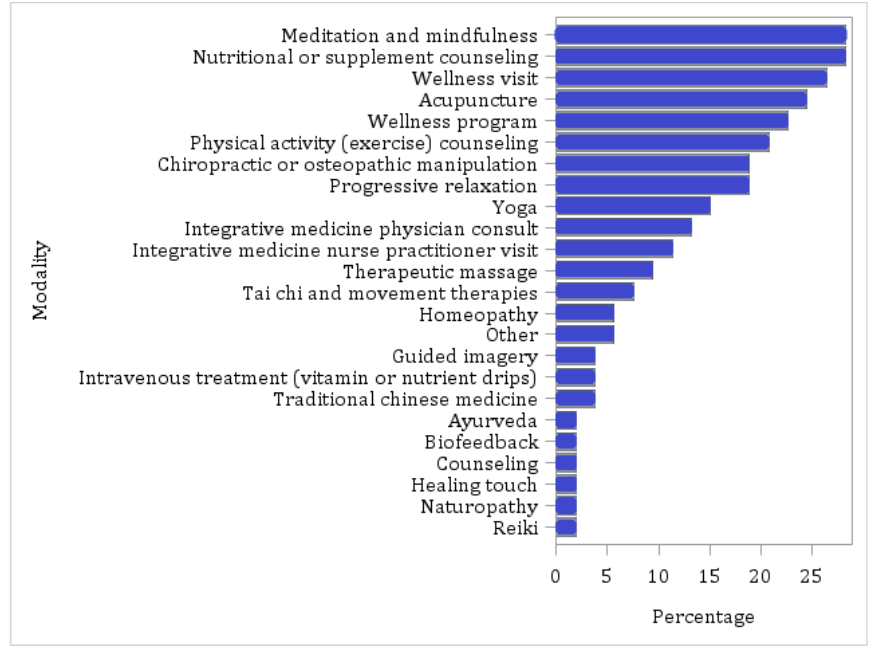
Figure 1. Frequency of reported unique modality use among those who reported use of at least one modality (n=53). The x-axis represents the percentage of patients reporting the modality shown on the